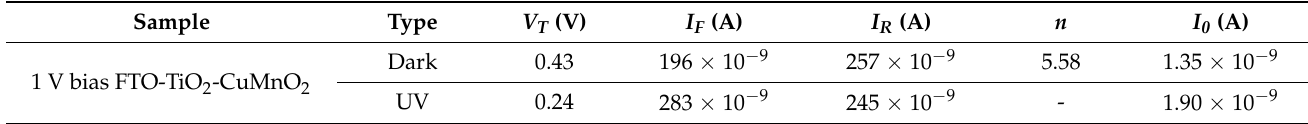
Figure 6. Current–voltage characteristics of the transparent heterojunction of n -TiO 2 / p -CuMnO 2 under dark and UV illumination ( a ); Log of forward and reverse bias under dark and UV-illuminated conditions. ( b ). Table 2. Electrical parameters of the FTO-TiO 2 -CuMnO 2